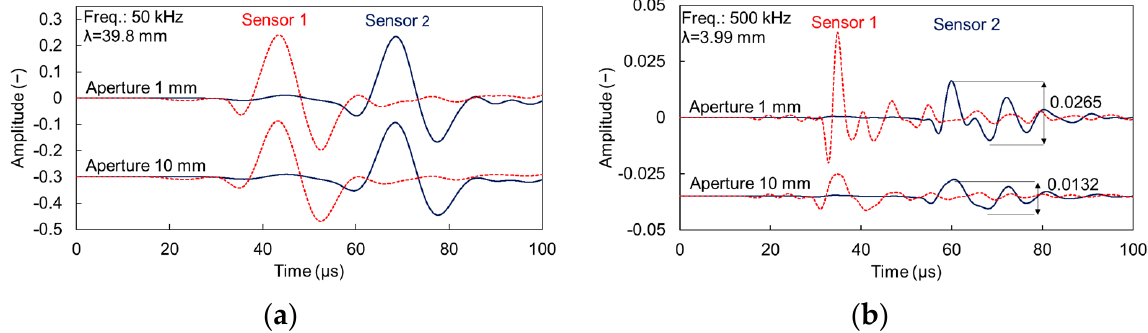
Figure 6. Simulated waveforms on cement matrix with 3% voids of 2 mm size for different apertures and excitation frequency of ( a ) 50 and ( b ) 500 kHz.